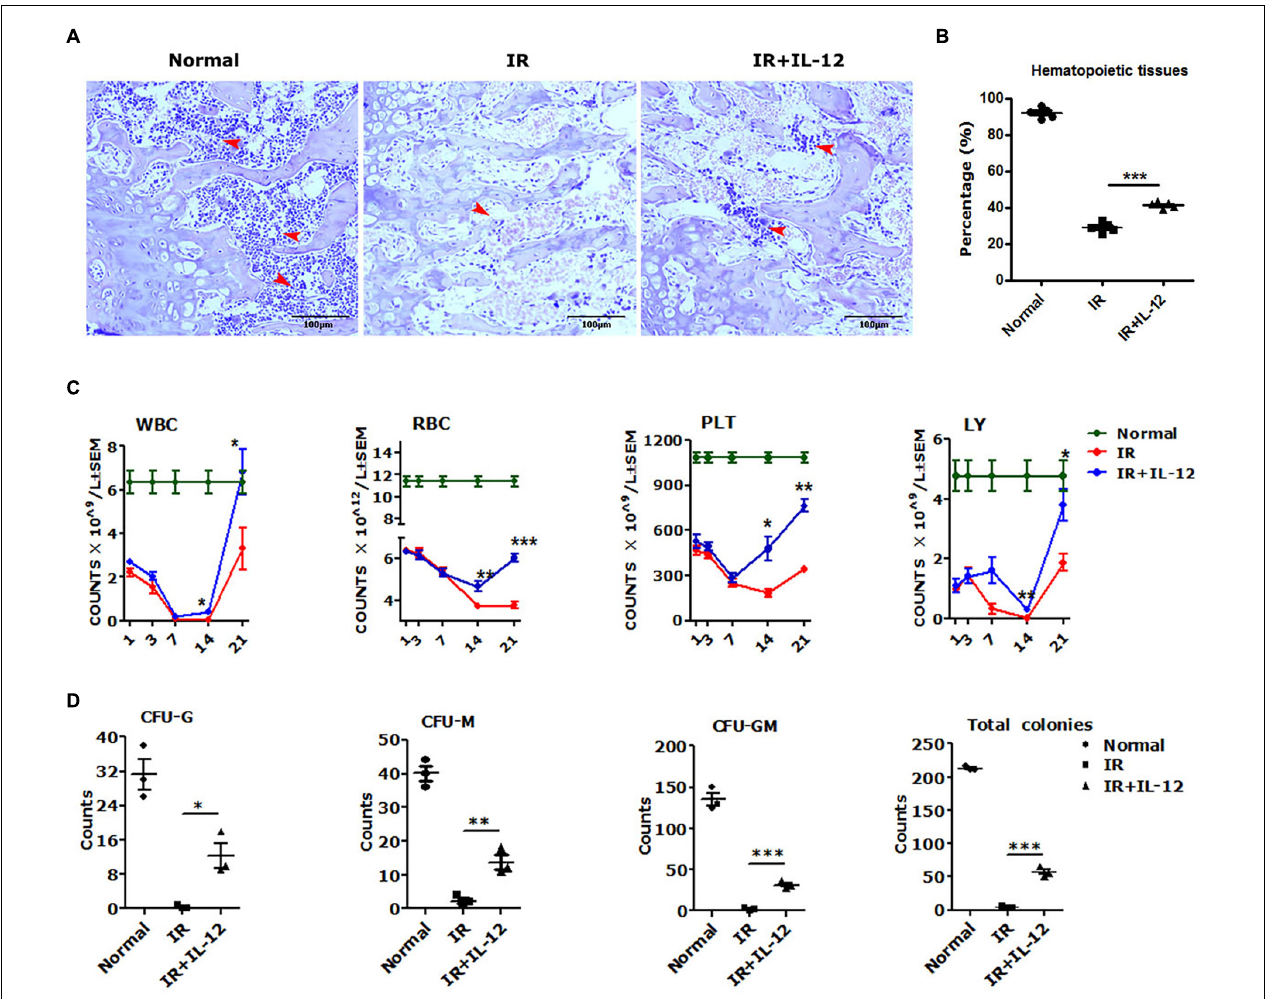
FIGURE 1 | IL-12 promoted the haematopoiesis recovery in 5 Gy irradiated mice. (A) Hematoxylin and eosin (HE) staining of irradiated and subcutaneous femurs injected with a single dose of 1 ng/g IL-12 mice. The magnifications are 200 × . Hematopoietic tissues were shown at the arrows (scale bar = 100 µ m). (B) The percentage of hematopoietic tissues of the femoral bone tissue sections of irradiated and injected with a single dose of 1 ng/g IL-12 mice. (C,D) The peripheral blood cells (PBCs) count and the hematopoietic stem and progenitor cells (HSPCs) colonies of irradiated and injected with a single dose of 1 ng/g IL-12 mice. The results were considered significant at * P < 0.05, ** P < 0.01 and *** P <